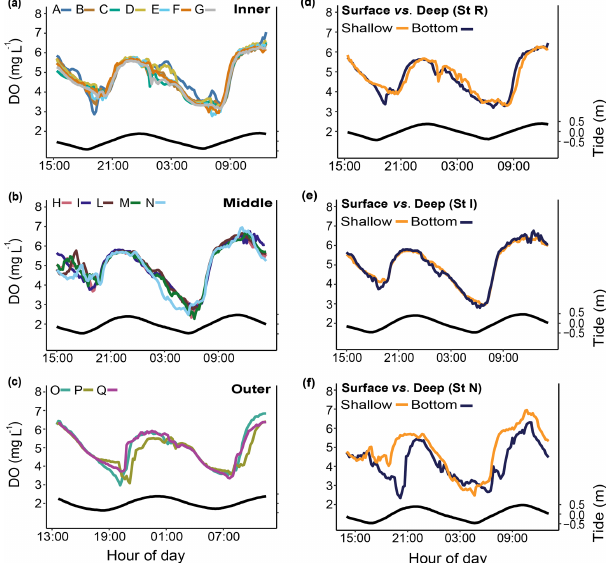
Figure 6. Spatial and depth-related short-term measurements (24h) of dissolved oxygen (DO) at stations in the Bouraké lagoon (see Fig. 1 for the location of the stations). Spatial variations were as- sessed at (a) the inner reef (Sts A–G), (b) the middle reef (Sts H–N), and (c) the outer reef (Sts O–Q). Depth-related variations between shallow reefs and bottom water within the Bouraké lagoon were as- sessed (d) at the inner reef (St R) and (e, f) at the middle reef (Sts I and N). Tide (black line) refers to St